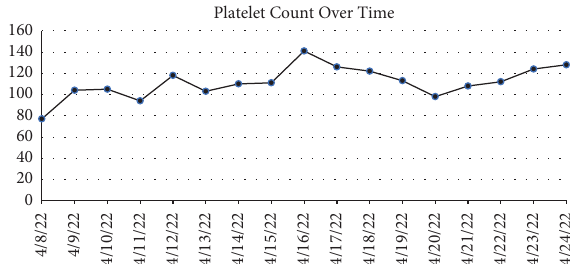
Figure 2: Platelet counts over time. Transfusions 1 and 2 with corresponding allergic reactions took place on 4/8/22. Transfusion 3 with pretransfusion medication to limit allergic reaction symptoms, a total of 2 units, took place on 4/11/22. Transfusion 4, similar to transfusion 3, but with 3 units in total took place on 4/12/ 22. Te CABG took place on